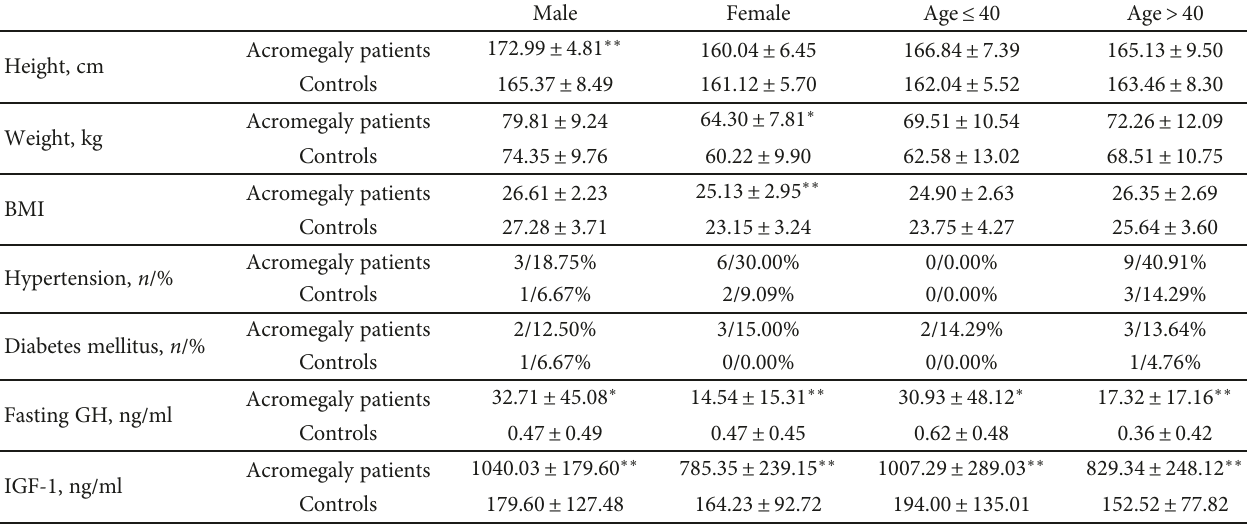
Table 1: Clinical characteristics of the acromegaly patients and the